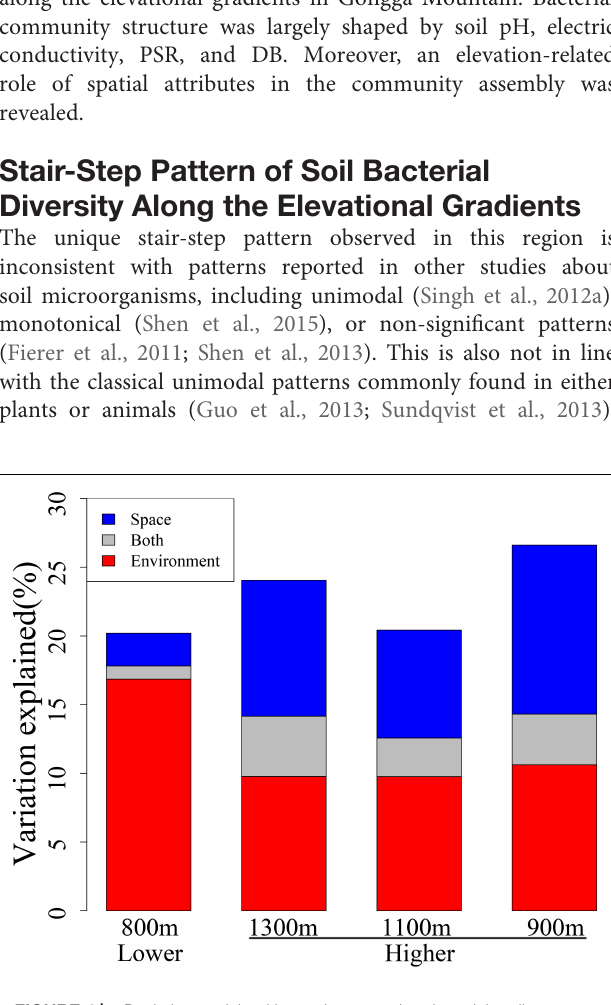
FIGURE 4 | β -Deviation explained by environmental and spatial attributes at different elevational sections, with forward selection model applied in a distance-based redundancy analysis (dbRDA). The scale of lower elevational section was 800 m (1800–2600 m) and scales of higher elevational